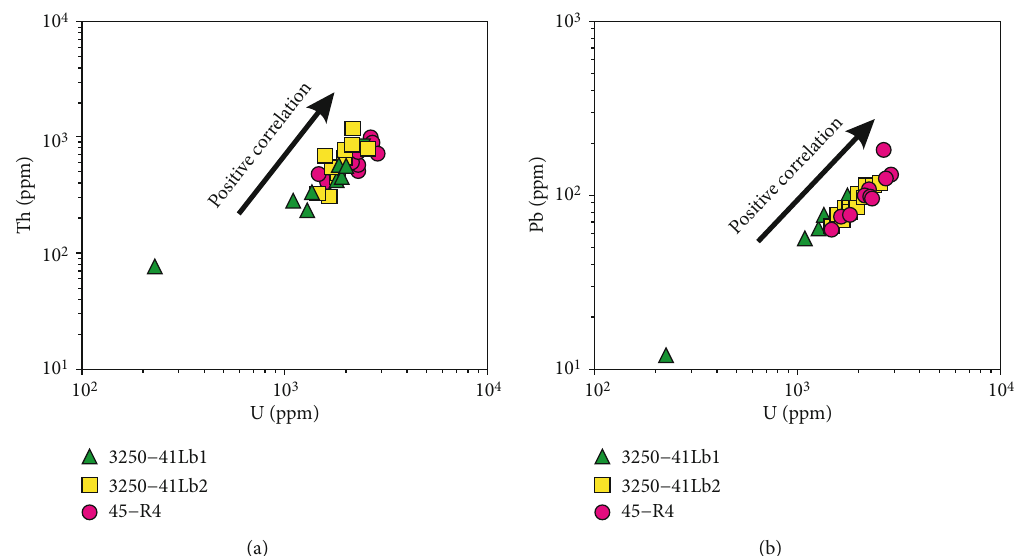
Figure 9: The covariant diagram of Th-U (a) and Pb-U (b) zircons from the granite porphyries in Yangla copper deposit, Yunnan,